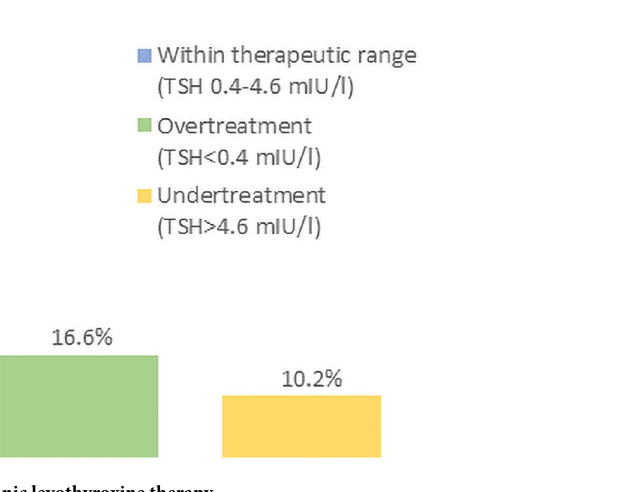
Fig 2. TSH levels under chronic levothyroxine